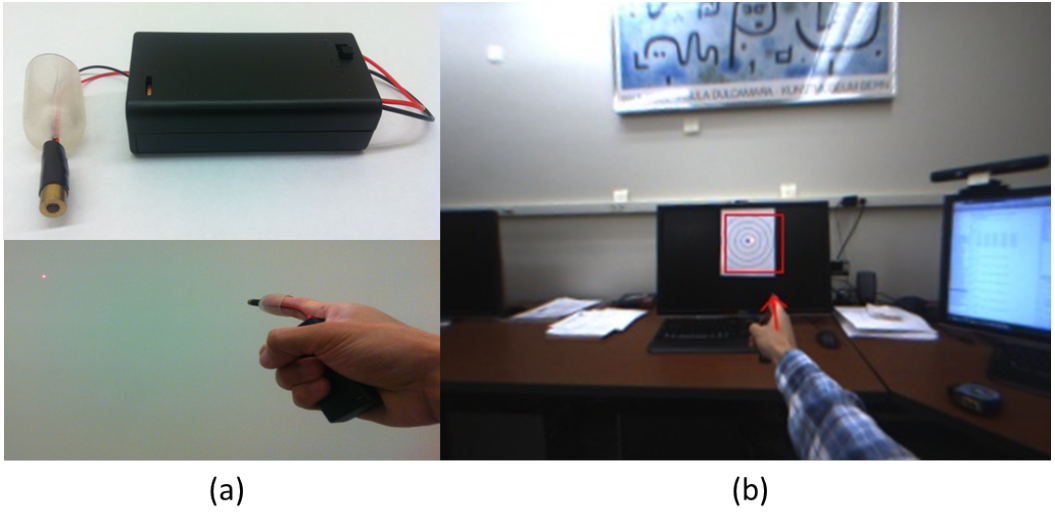
Figure 13. Quantitative experimental setup to evaluate our finger pointing algorithm with a laser pointer (ground truth): ( a ) a laser pointer attached to the top of the index finger and ( b ) the experiment with a target circle image at a distance (1 m).